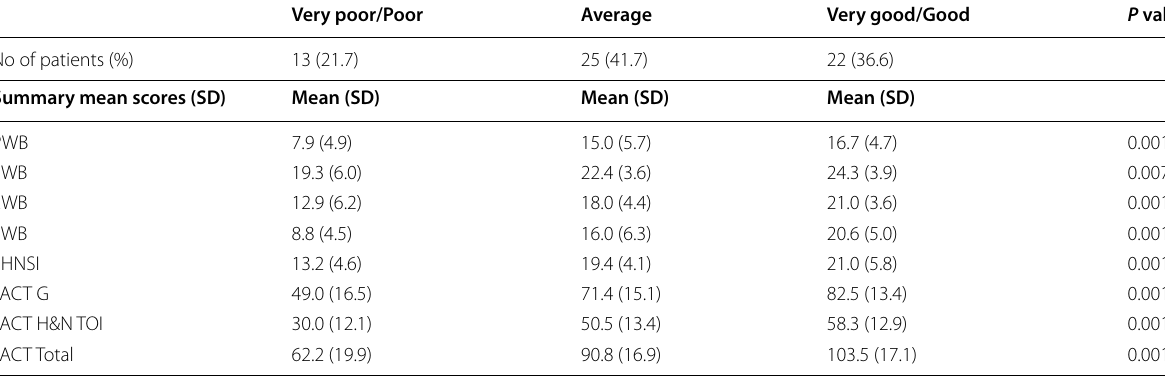
Table 3 Cross sectional validity